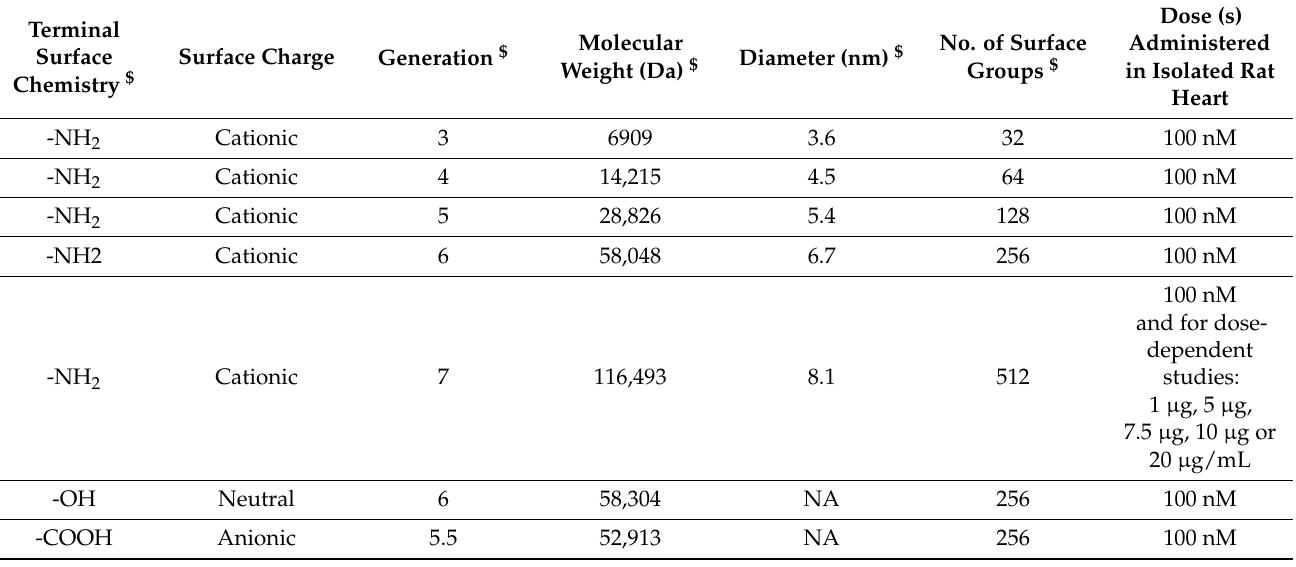
Table 1. List of PAMAM dendrimers, their nominal physicochemical properties and dosages used in this